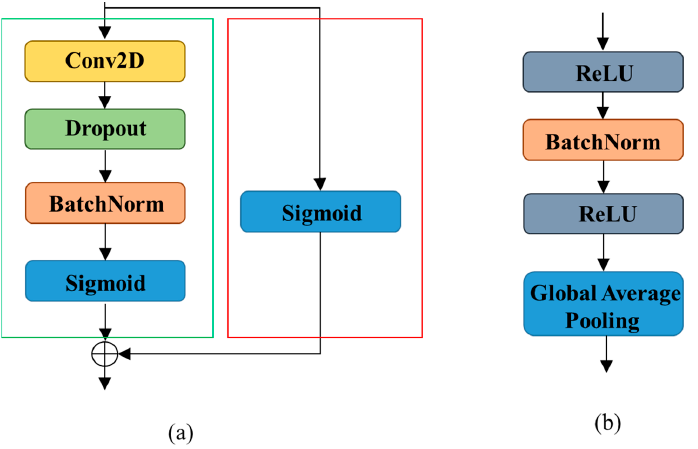
Figure 4. Two components of the proposed residual pooling layer. ( a ) Residual encoding module and ( b ) aggregation module.